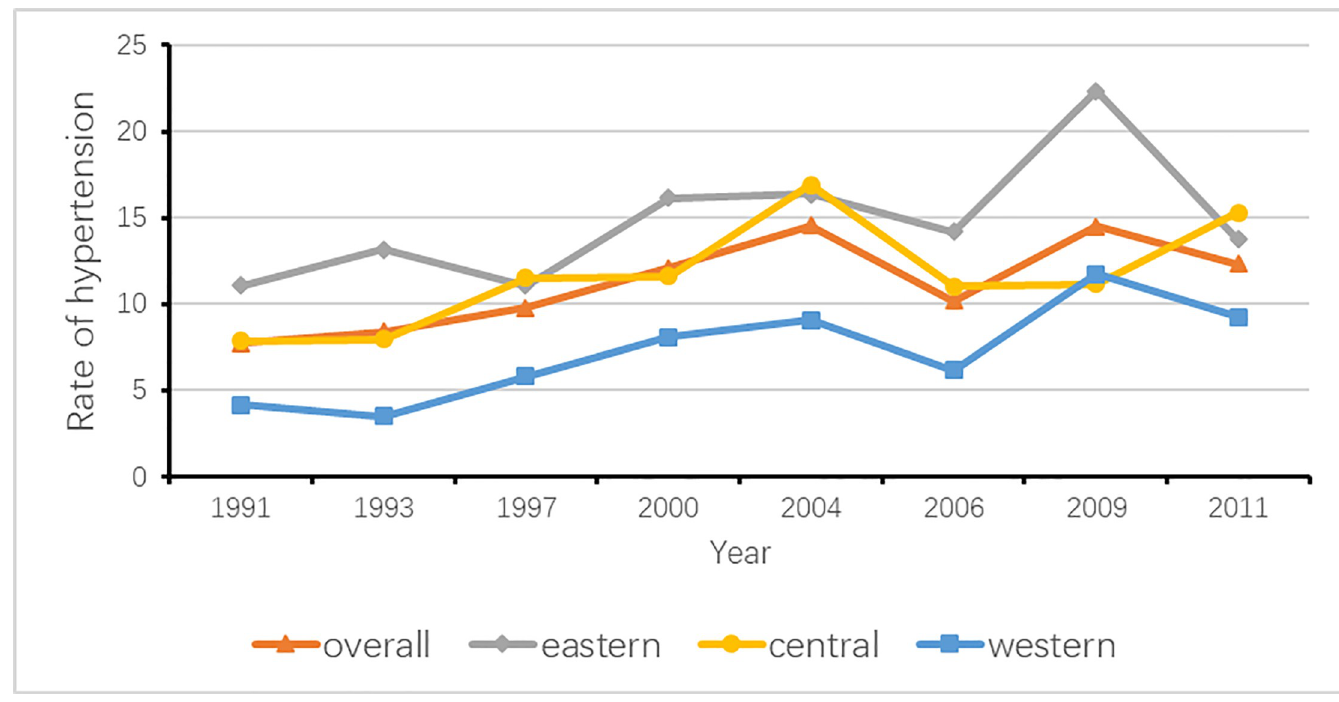
Fig 2. Trends of hypertension by survey